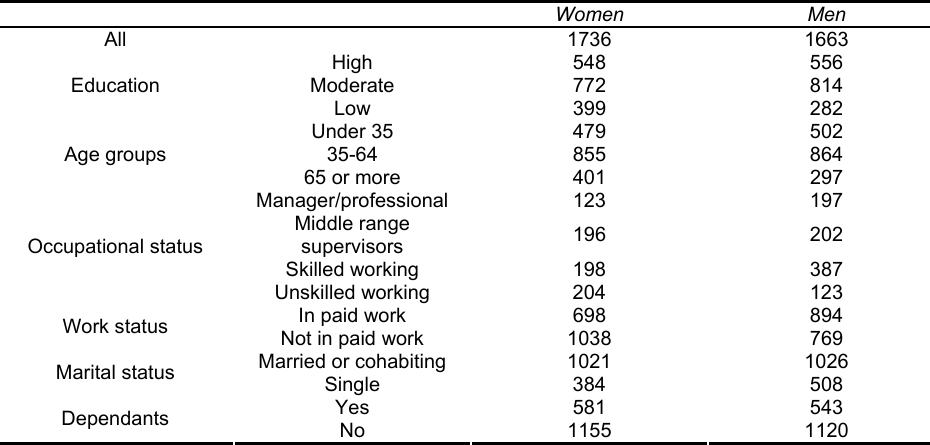
Table 2. Description of the sample by independent